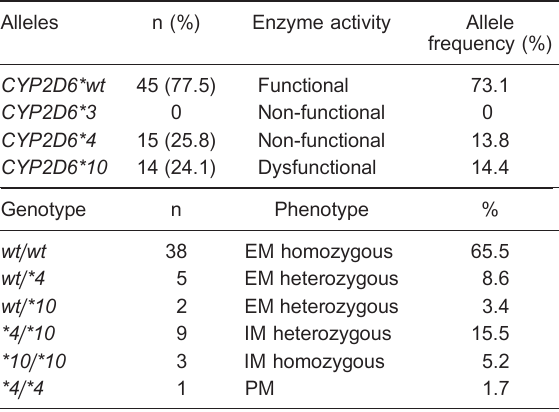
Table 3. Allele and genotypic frequency and distribution of